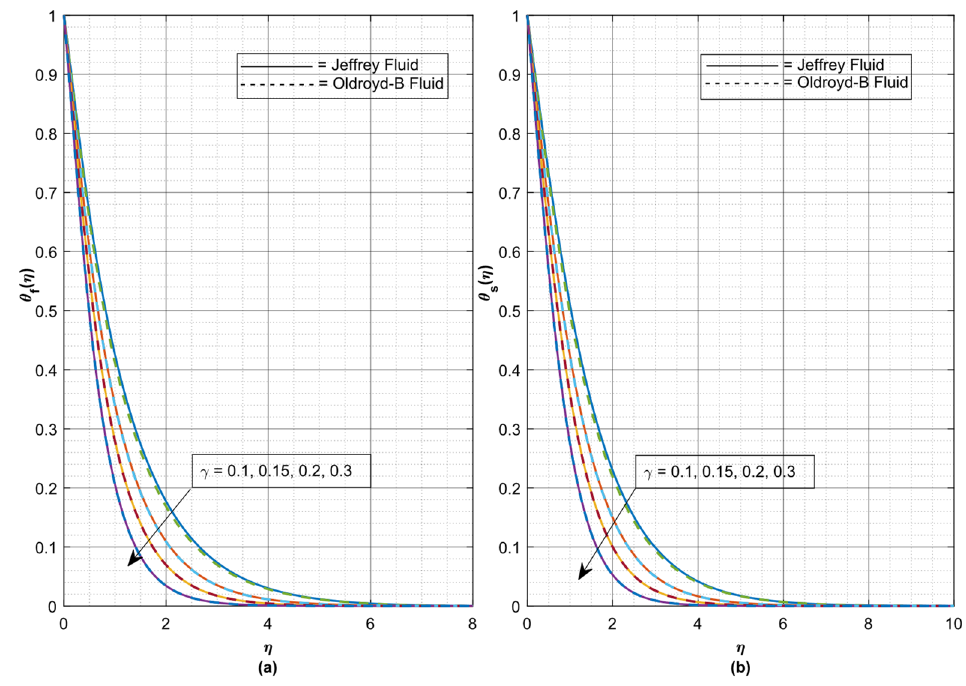
( ) θ η . Figure 3. ( a ) Impact of M on f f